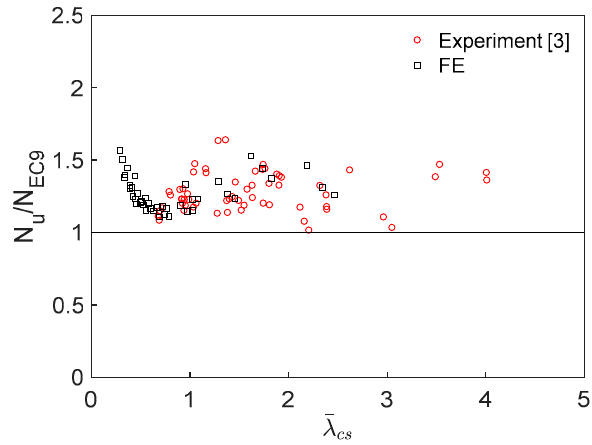
Figure 10. Assessment of EC9 design strength predictions.